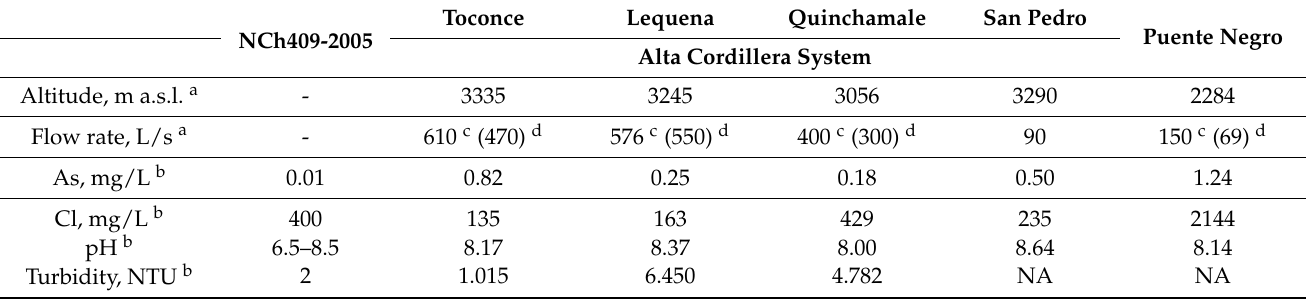
Table 1. Quality of the waters collected from the five catchment points that feed the Calama (Cerro Topater) and Antofagasta (Old and New Salar del Carmen)